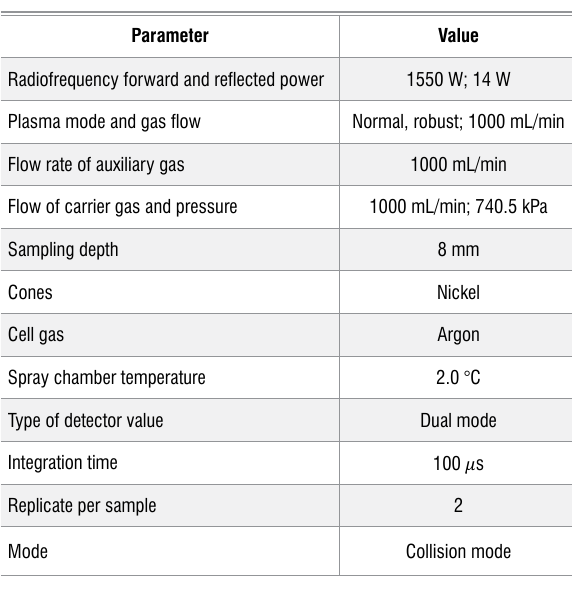
Set-up parameters for the inductively coupled plasma